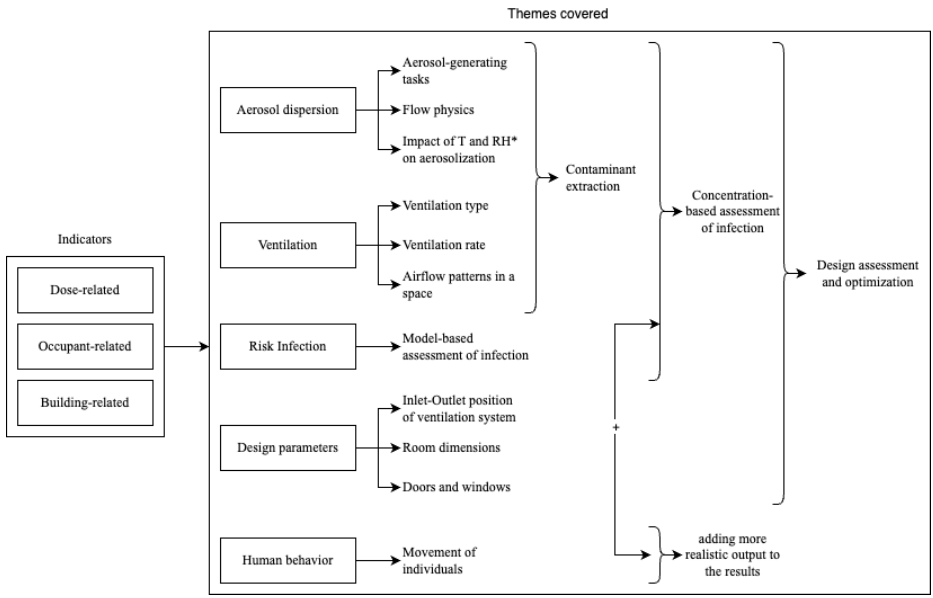
Figure 4. A summary of the themes discussed in this review, the topics addressed, and the indica- tors